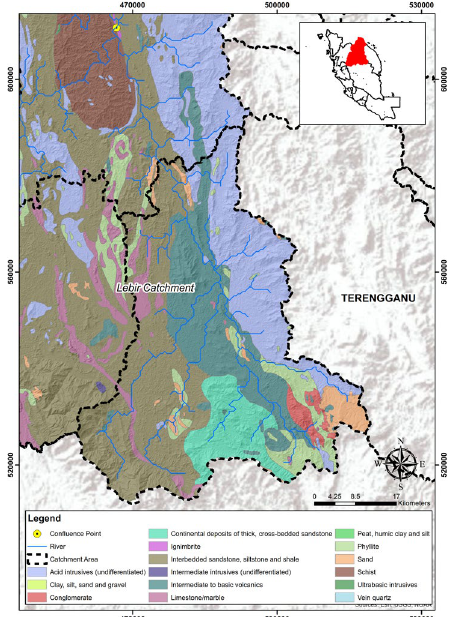
Figure 3. Geological map of Sungai Lebir catchment